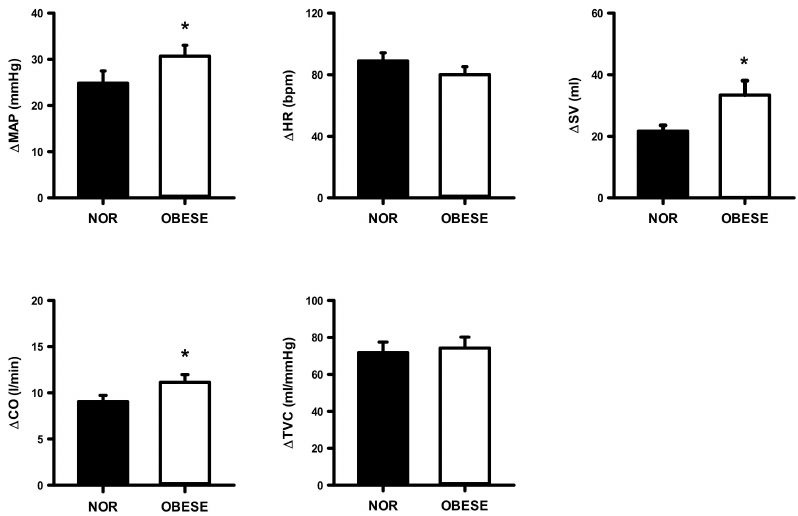
Figure 7. Changes from rest in mean arterial pressure (MAP), heart rate (HR), stroke volume (SV), cardiac output (CO), and total vascular conductance (TVC) during the 30% of VO 2peak workload in normal and obese individuals. Black bar, normal; open bar, obese. * p < 0.05, vs. normal individuals.